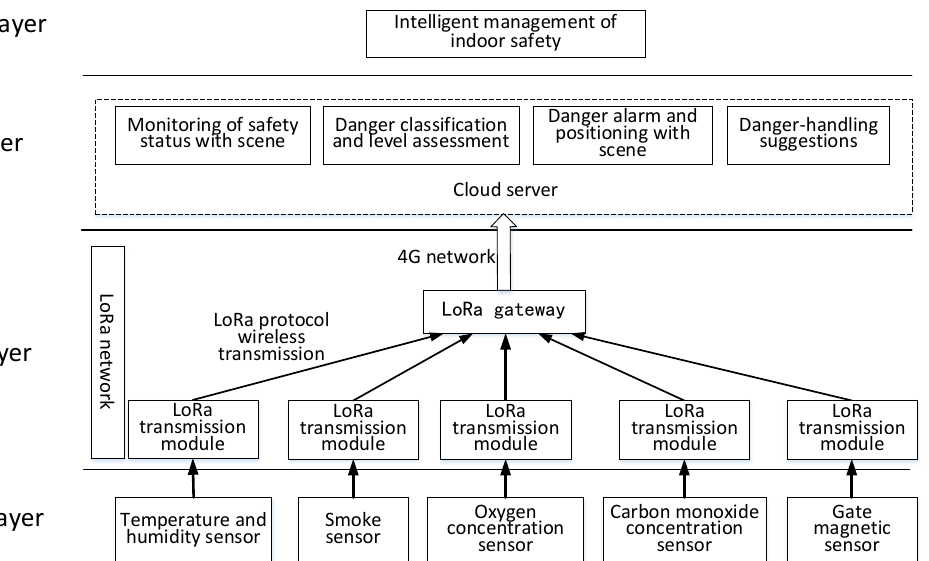
Figure 4. IoT structure of the indoor safety management system based on LoRa technology.